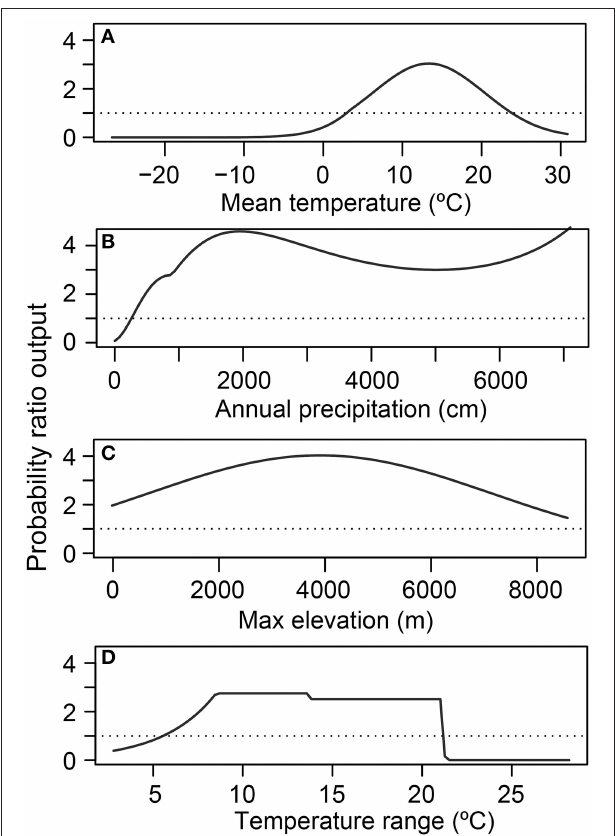
FIGURE 4 | Relative habitat suitability of Batrachochytrium dendrobatidis ( Bd ) occurrence (probability ratio output) for each environmental attribute [ (A) mean temperature; (B) annual precipitation; (C) maximum elevation; (D) temperature range] from the global presence-only best-fit species distribution model. Each environmental attribute marginal-response plot is calculated while holding all other covariates at the mean.